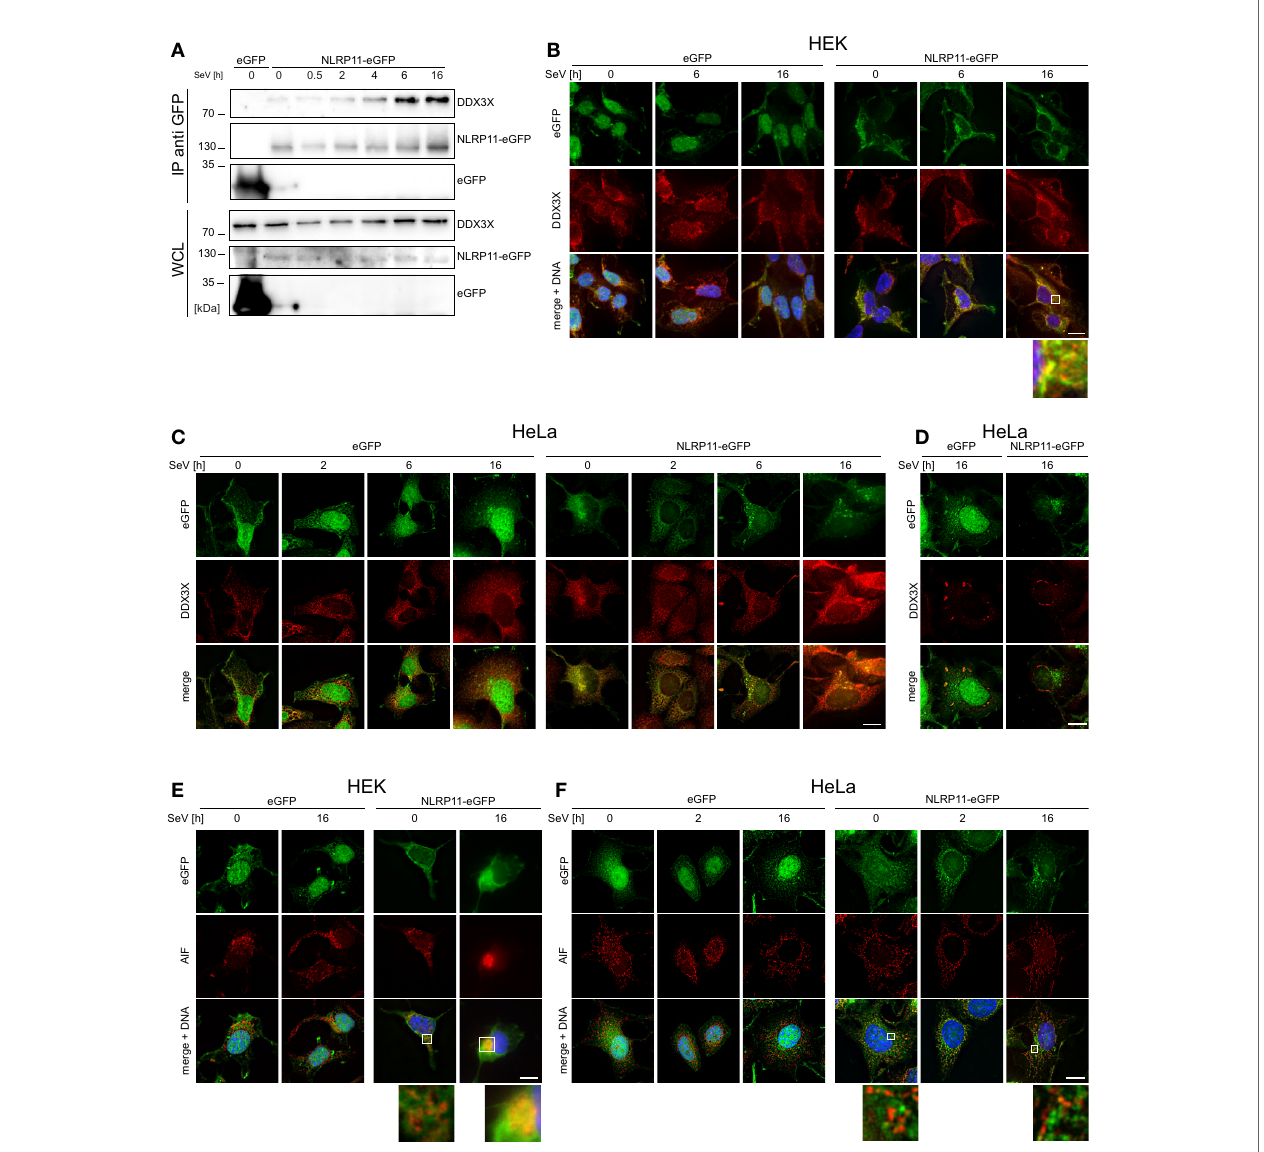
FIGURE 2 | Interaction and co-localization of NLRP11 and DDX3X upon infection. (A) Co-immunoprecipitation of NLRP11-eGFP from HEK293-eGFP and HEK293- NLRP11-eGFP cells after induction with doxycycline overnight and infection with SeV for the indicated time. Immunoblots of the IPs and whole cell lysates (WCL) were probed for DDX3X and GFP. The blots are representative of two independent experiments. (B – F) Indirect immuno fl uorescence micrographs of HEK293 (B, E) , or HeLa- (C, D, F) , eGFP or NLRP11-eGFP cells induced with doxycycline overnight and infected with SeV for the indicated time. 3D deconvolution of DDX3X (B – D) , or AIF (E, F) staining (red), together with the eGFP signal (green) are shown. Nuclei are stained with Hoechst (blue). Scale bars = 10